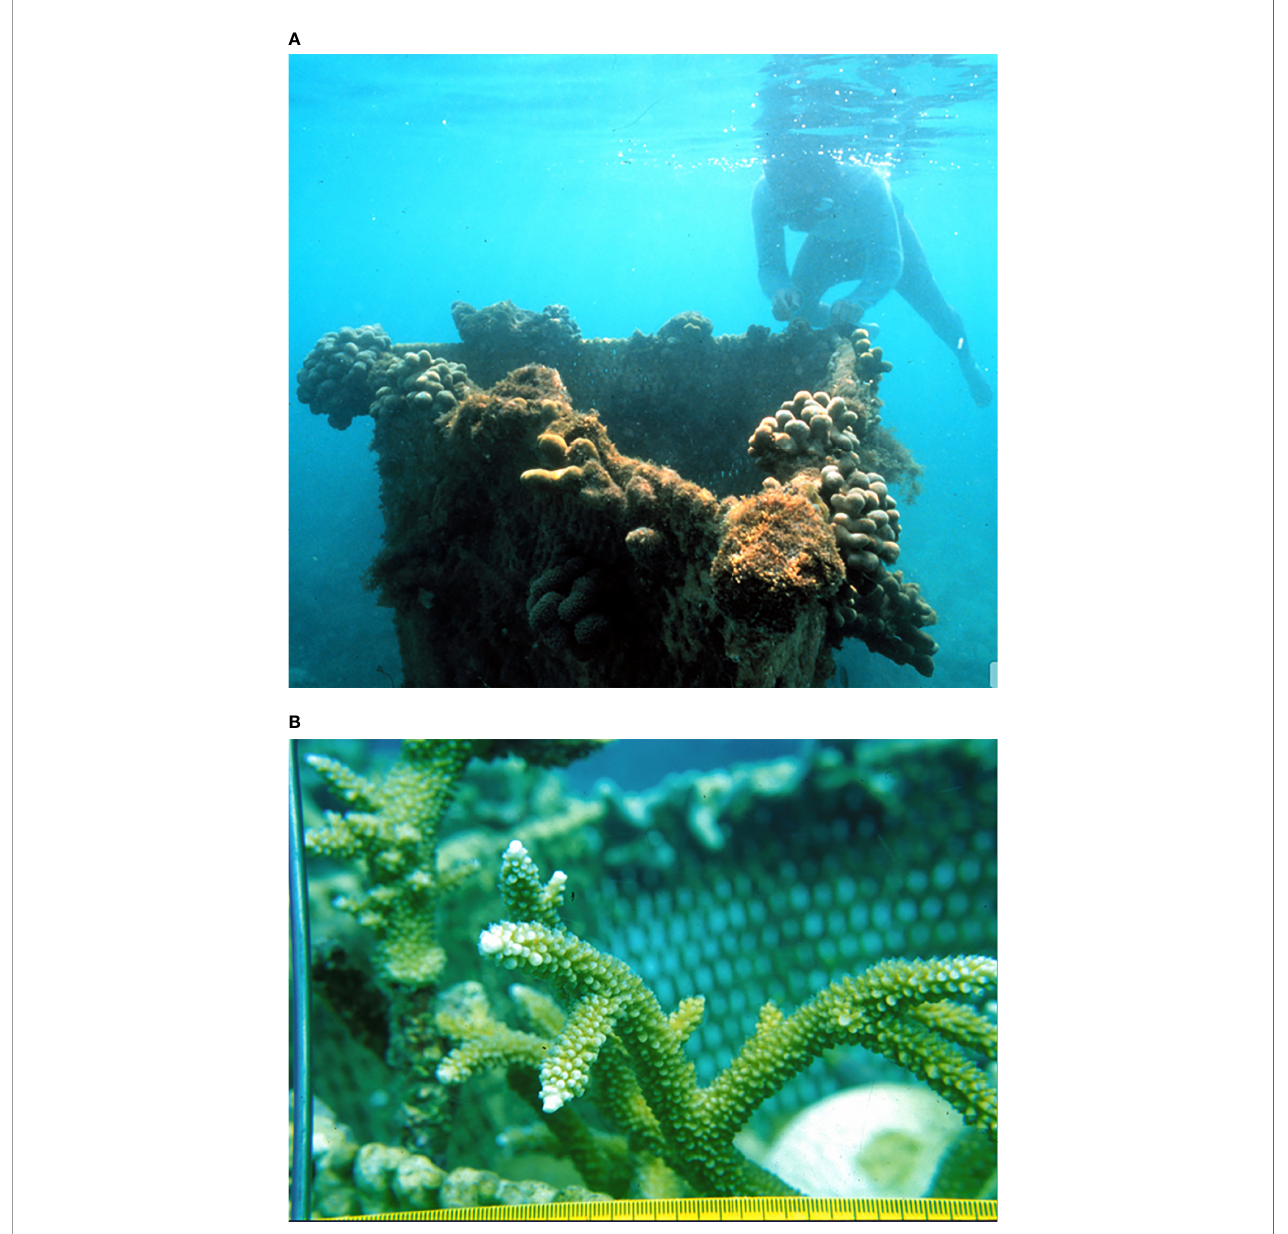
FIGURE 1 | (A) The proli fi c growth of Porites porites on Biorock. Densely branching Porites porites colonies are interspersed with sand-producing red coralline algae that grew spontaneously (front corner of Biorock reef). Discovery Bay, Jamaica, 1989 photograph by Dr. Peter Goreau. (B) Acropora cervicornis grew 0.8 cm per week in an area of poor water quality. Negril, Jamaica, 1991 photograph by Wolf